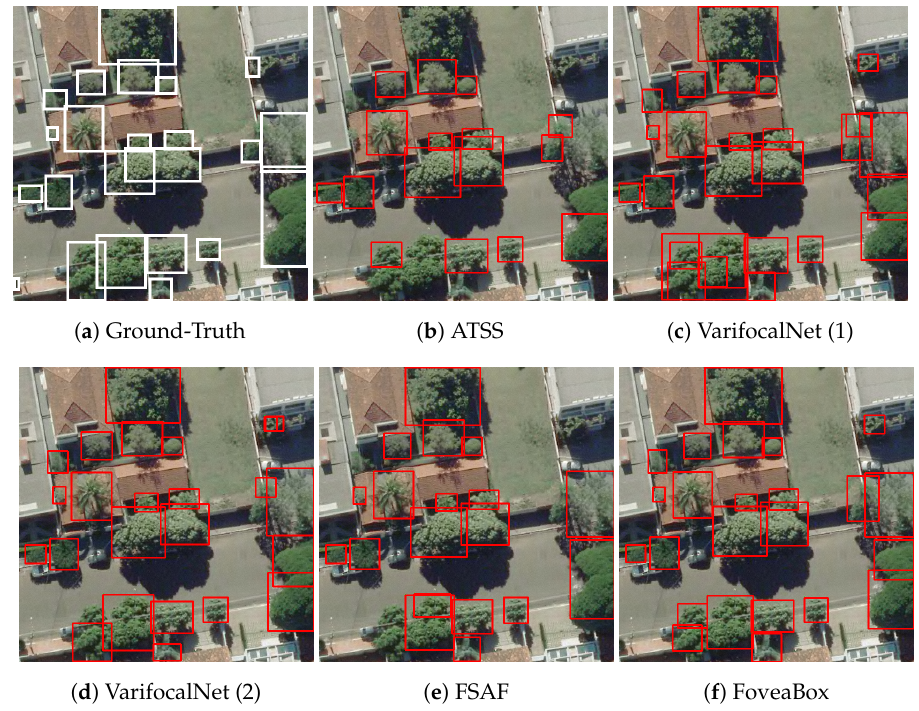
Figure 10. Example of tree detection using anchor-free methods.